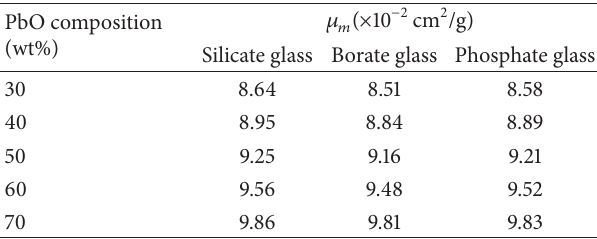
Table 1: Total mass attenuation coefficients of PbO containing silicate, borate, and phosphate glass systems at 662